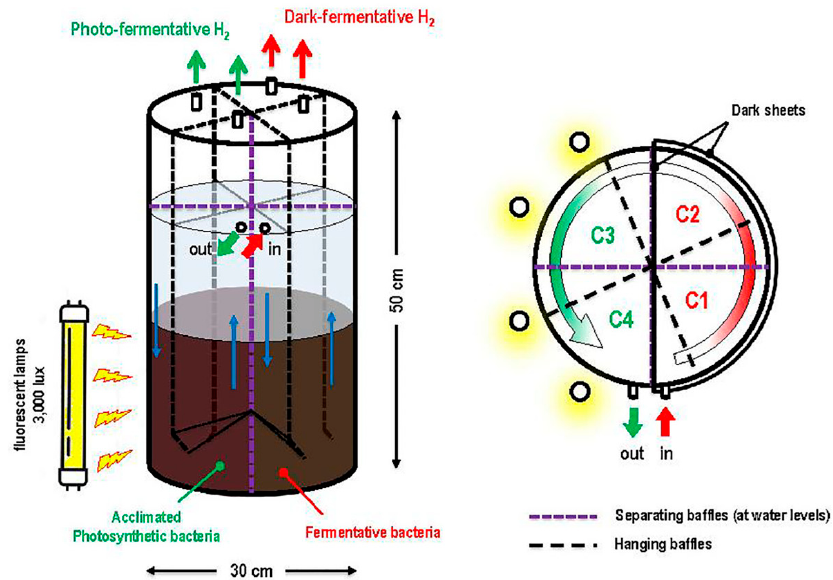
Figure 9. Schematic diagram for the lab-scale dark-photo circular baffled reactor used for anaerobic treatment of gelatinaceous wastewater [150] .